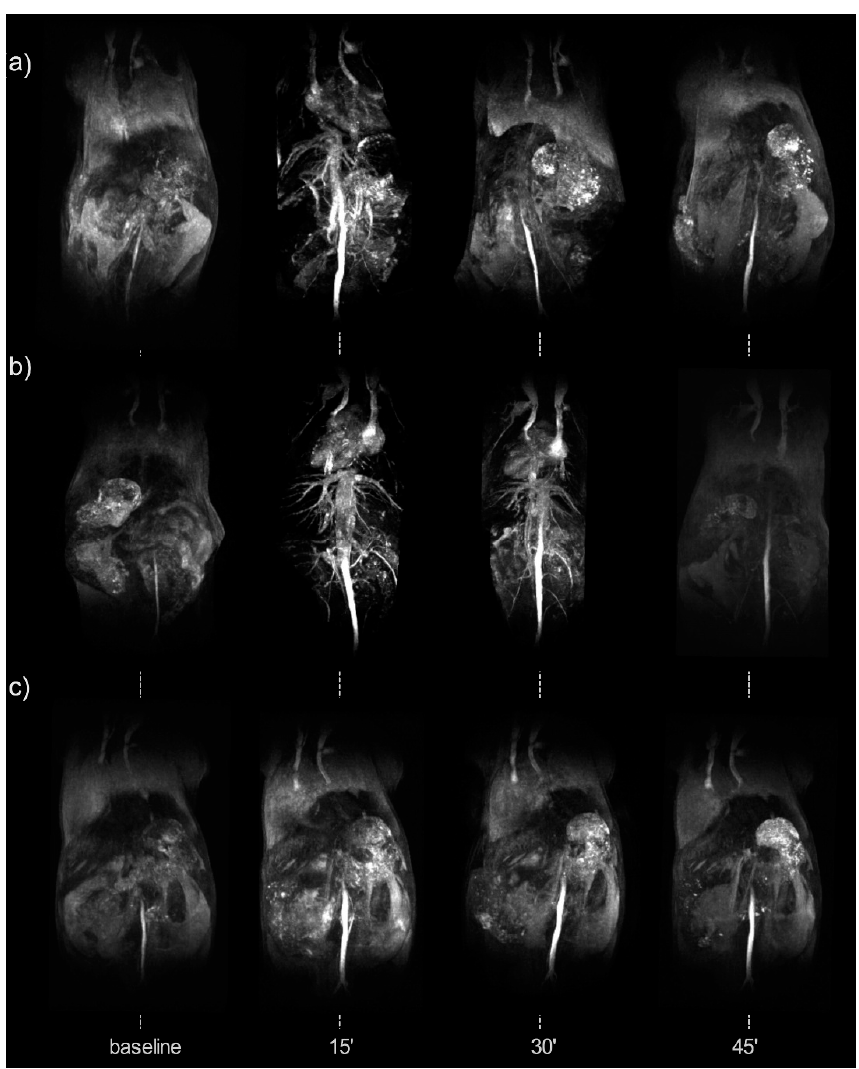
Figure 10. MRI ( T 1 -weighted imaging) body angiography in healthy mice, before and after the intravenous injection of ( a ) 1.7% Cu-doped NPs, ( b ) 4% Cu-doped NPs, and ( c ) 28% Cu-doped NPs. Reproduced with permission from Reference [41].